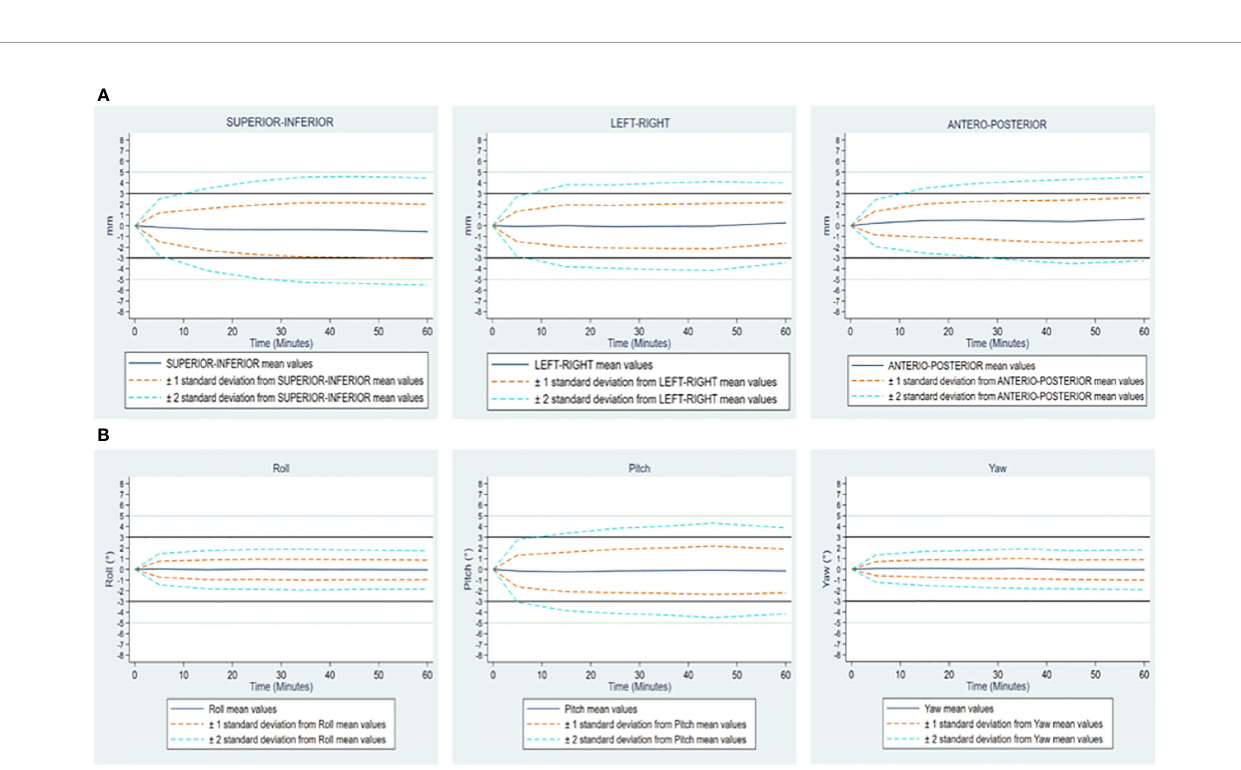
FIGURE 2 | Distribution of the deviation according to time in 10-minute intervals, across all patients.